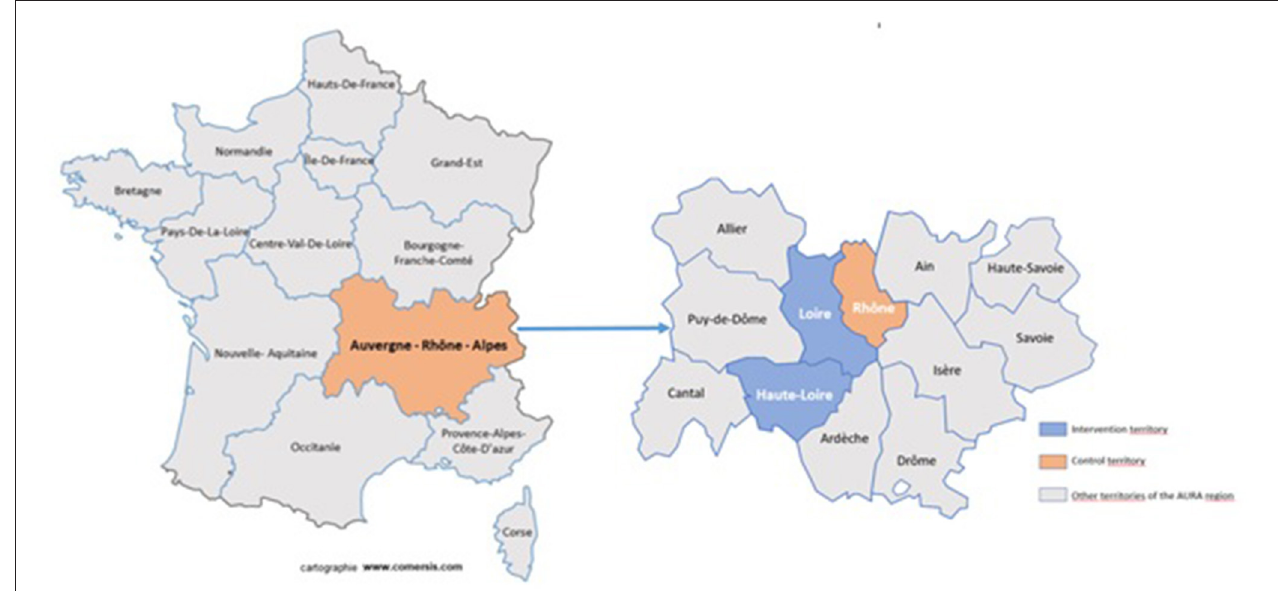
FIGURE 1 | Test and control areas of the